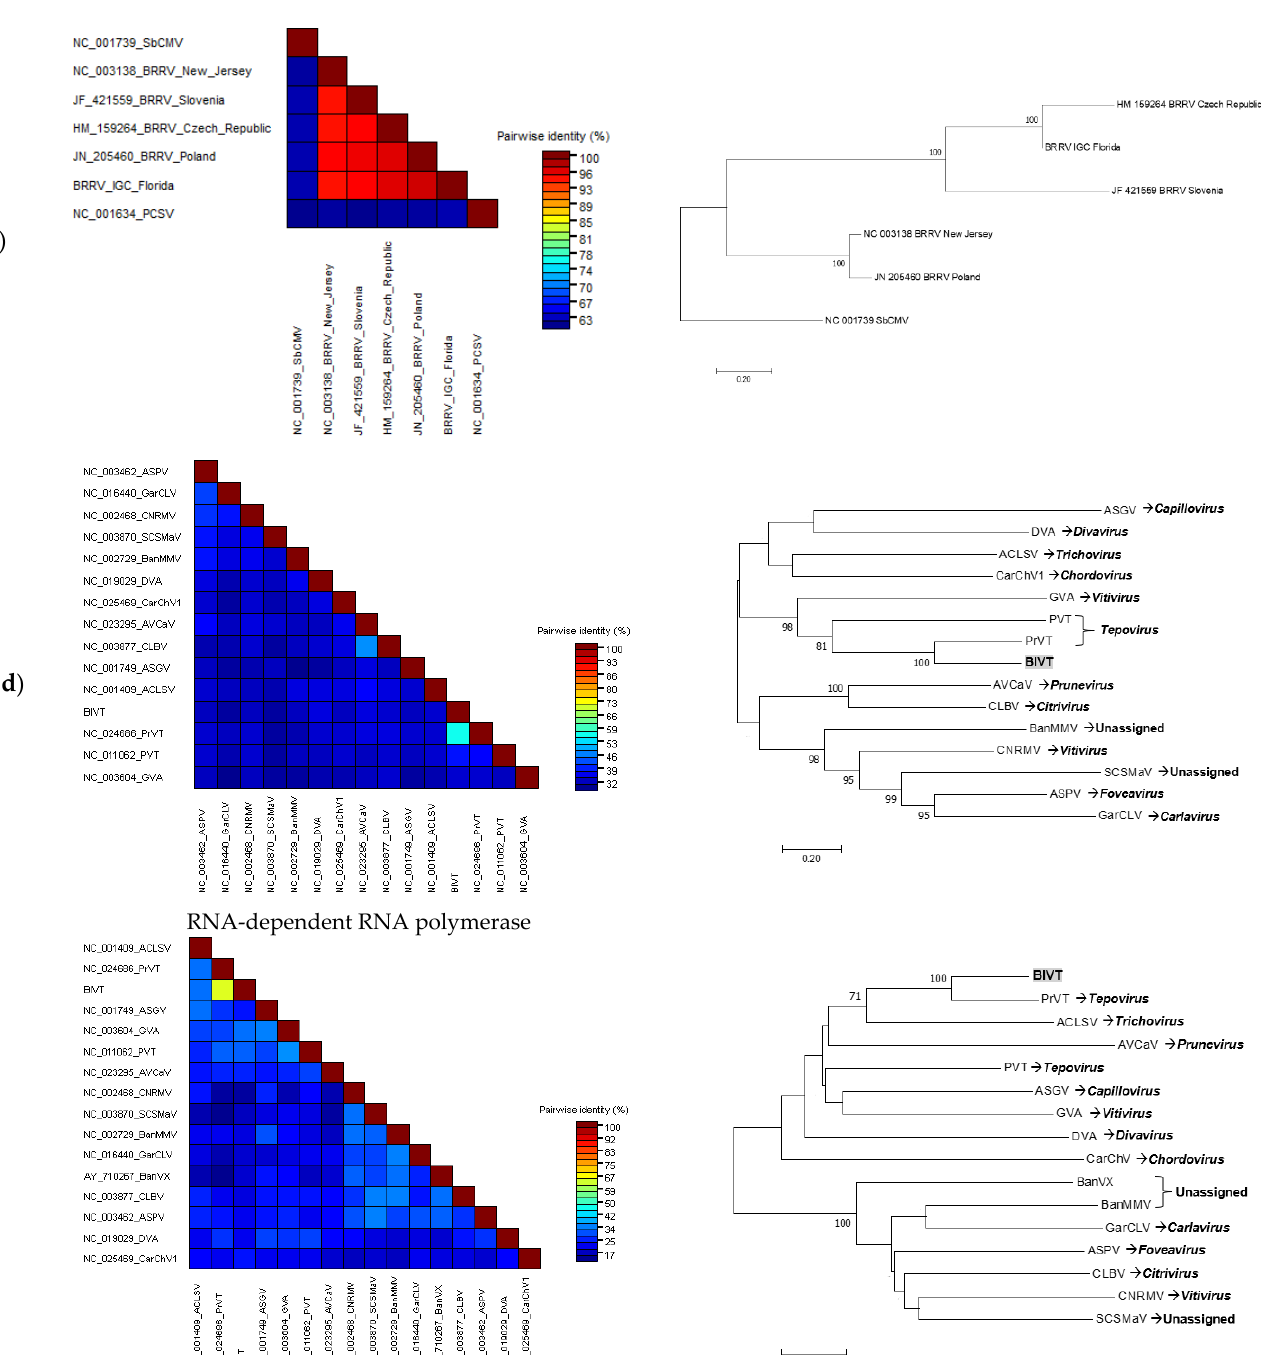
Figure 4. The pairwise comparison analysis in SDT and phylogenetic analysis in MEGA7 using nucleotide and amino acid sequences of different genome regions of the respective viruses. Pairwise sequence identities between the viruses are represented in different colors. The bootstrap consensus phylogenetic tree was constructed by neighbor-Joining using the Maximum Composite Likelihood and Poisson correction method for nucleotide and amino acid sequences, respectively, based on 1000 replicates, showing branch nodes more than 75% bootstrap values. ( a ) Pairwise identity and phylogenetic analysis using the full genome of BlLV isolates and selected members of the genus Amalgavirus . ( b ) Pairwise identity and phylogenetic analysis using the NP gene of BlMaV isolates and selected members of the genus Ophiovirus . ( c ) Pairwise identity and phylogenetic analysis using the full genome of BRRV isolates and selected members of the genus Soymovirus . ( d ) Pairwise identity and phylogenetic analysis using the RdRp and CP protein of the putative novel Tepovirus and se- lected members representing different genera in the family Betaflexiviridae . Accession numbers are shown in the figure. ACLSV, apple chlorotic leaf spot virus; ASGV, apple stem grooving virus; ASPV, apple stem pitting virus; AVCaV, apricot vein clearing associated virus; BanMMV, banana mild mosaic virus; BanVX, banana virus X; BBLV, blueberry latent virus; BlMaV, blueberry mosaic associated ophiovirus; BlVT, blueberry virus T; BRRV, blueberry red ringspot virus; CarChV1, carrot Ch virus 1; CLBV, citrus leaf blotch virus; CNRMV, cherry necrotic rusty mottle virus; CPsV, citrus psorosis virus; DVA—diuris virus A; GarCLV, garlic common latent virus; GVA, grapevine virus A; LRNV, lettuce ring necrosis virus; PCSV, peanut chlorotic streak virus; PrVT, prunus virus T; PVT, potato virus T; RVA, rhododendron virus A; SbCMV, soybean chlorotic mottle virus; SCSMaV, sugarcane striate mosaic-associated virus; STV, southern tomato virus. Adapted from [5].